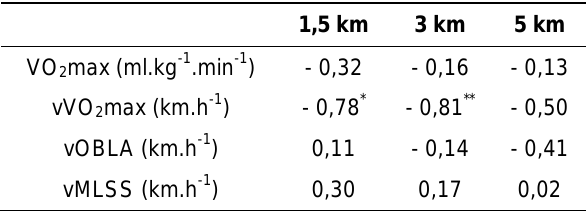
Tabela 2. Valores de correlação das variáveis fisiológicas com a performance nas distâncias analisadas.